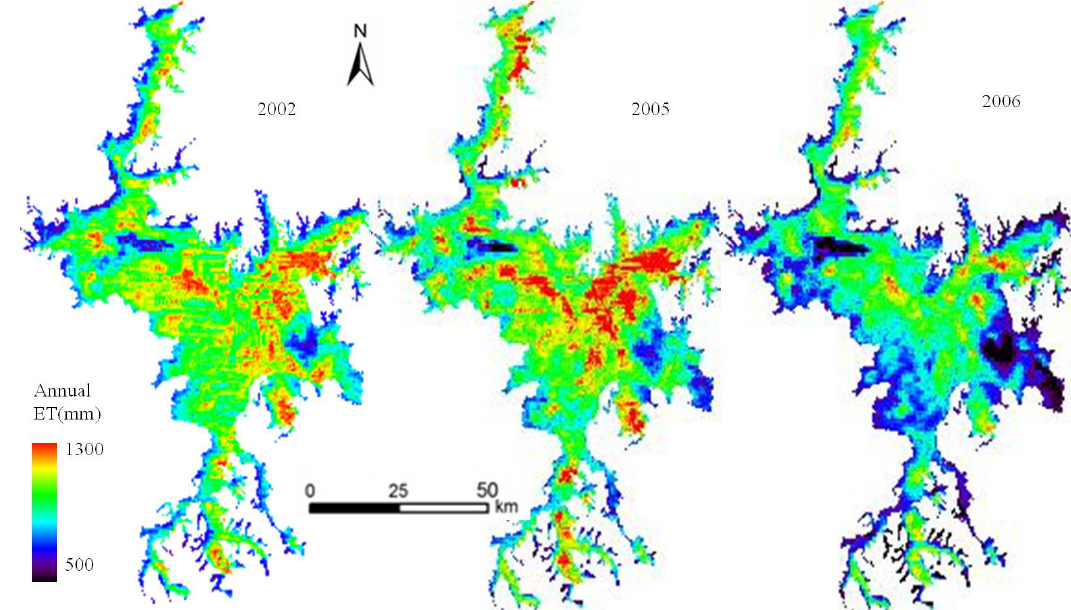
Figure 6. Spatial distribution of annual ET for wet (2002), normal (2005), and dry years